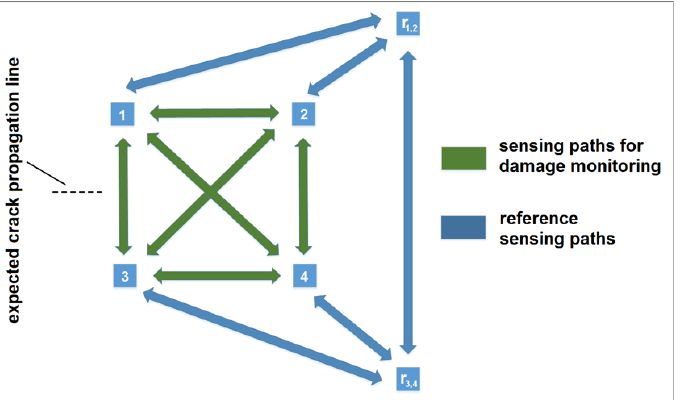
Figure 1. An example of a PZT network containing reference